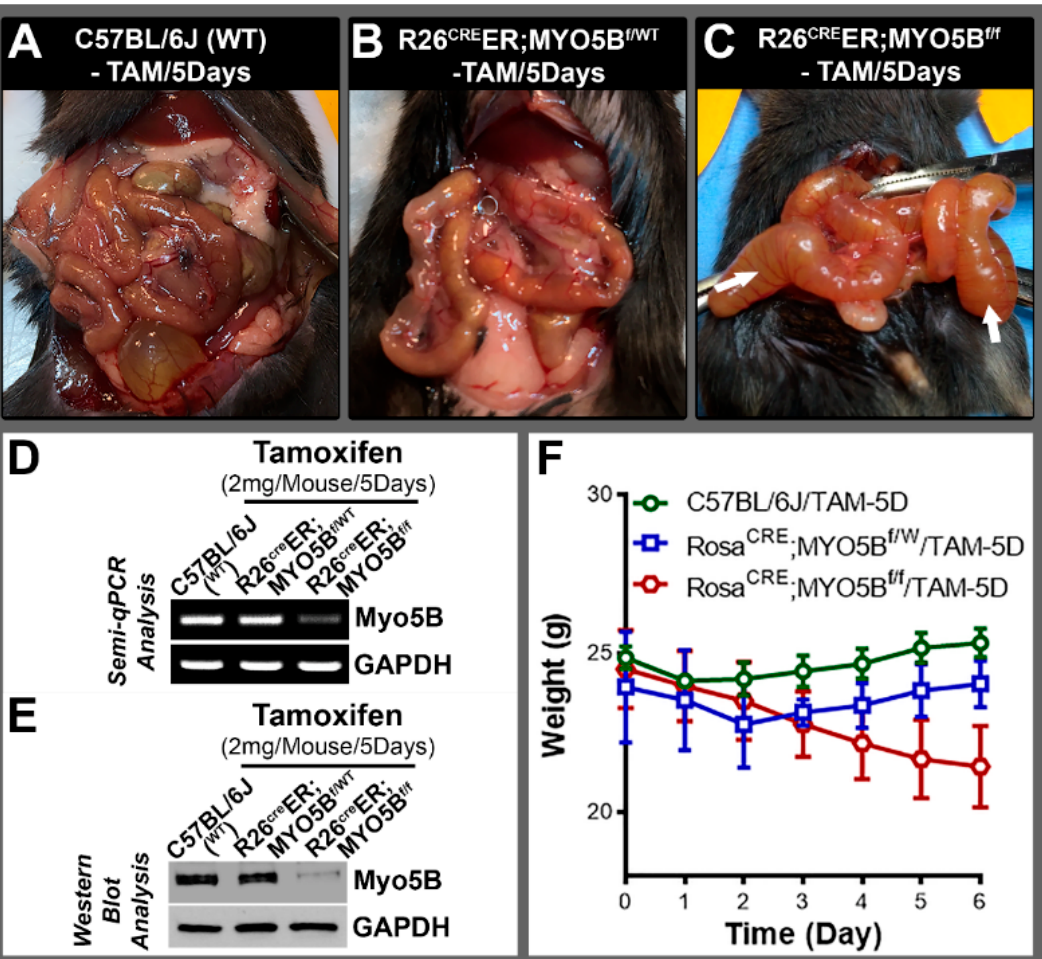
Figure 2. Tamoxifen induction at 5 days results in severe diarrhea in R26 Cre ER;MYO5B f/f (Homozygous) mice. A representative images of mouse intestines of ( A ) C57BL/6J (WT), ( B ) R2 Cre ER;MYO5B f/wt (Heter- ozygous), and ( C ) R26 Cre ER;MYO5B f/f (Homozygou s ) mice following 5 days treatment with tamoxifen (2 mg/day/mouse). Tamoxifen-treated homozygous mouse intestine display markedly distended loops with fluid-filled bowel (arrows) and severe diarrhea. ( D ) Semi-QRT-PCR analysis of mRNA from mucosal scrapings of tamoxifen-treated WT, R26 Cre ER;MYO5B f/wt and R26 Cre ER;MYO5B f/f jejunum con- firmed loss of Myo5B mRNA expression in the R26 Cre ER;MYO5B f/f mice. GAPDH was used as a loading control. ( E ) Immunoblots of mucosal lysates from small intestines confirmed the loss of MYO5B protein in tamoxifen-treated R26 Cre ER;MYO5B f/f mice compared with WT and R26 Cre ER;MYO5B f/wt mice. GAPDH